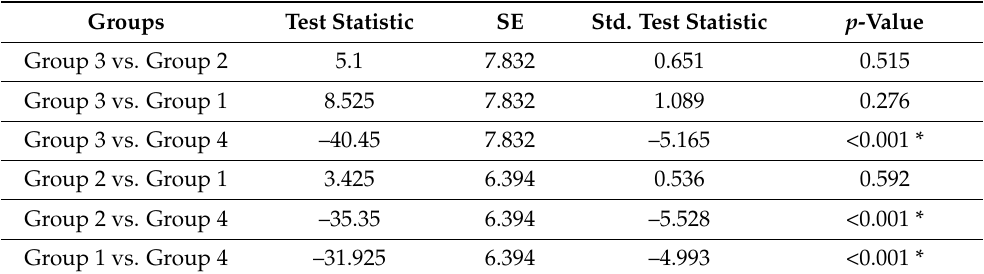
Table 4. Pairwise Dunn–Bonferroni comparative analysis of slot height in the four groups investigated ( p < 0.05 *).